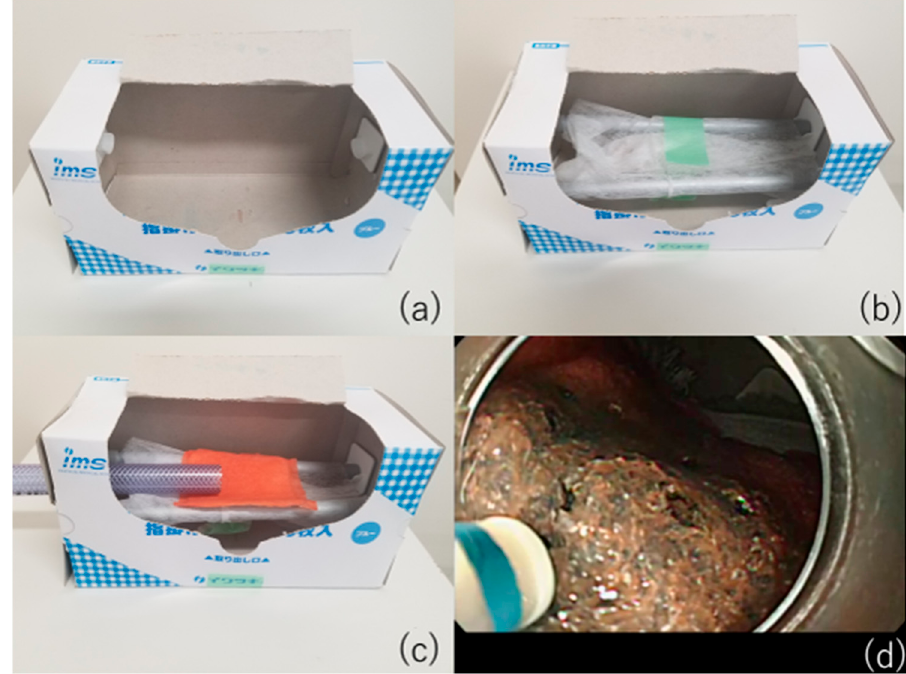
Figure 6. VTT ESD training model without special items. ( a ) An empty plastic apron box. ( b ) Place two rods in the box and wrap gauze around them like a stretcher. ( c ) Penetrate the hose into the box and place the VTT on the gauze. ( d ) A view during training with the VTT “konjac”, a food item model.